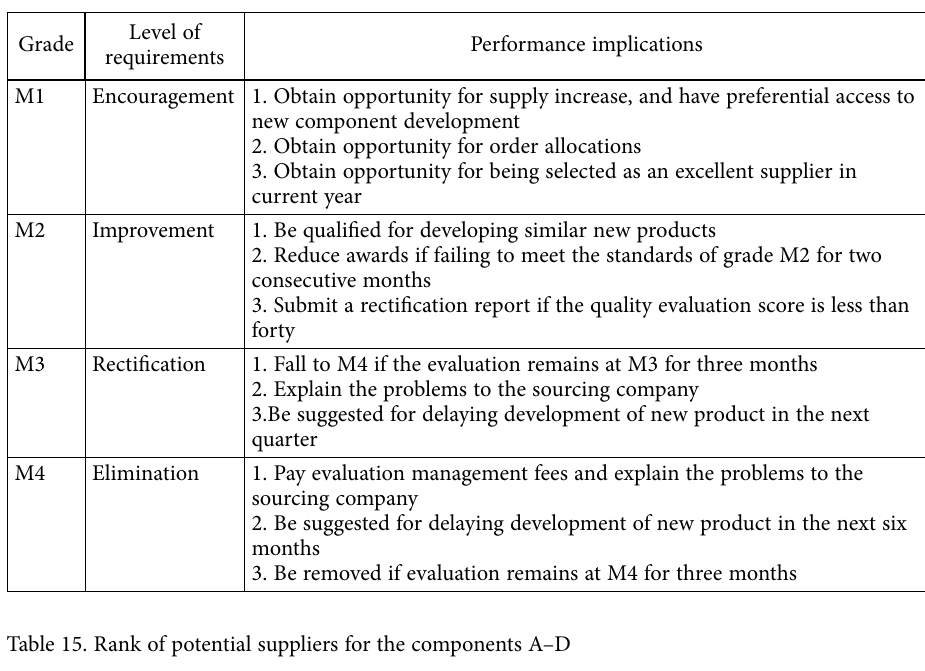
Table 14. Management requirements and performance implications for the four grades Level of Grade requirements